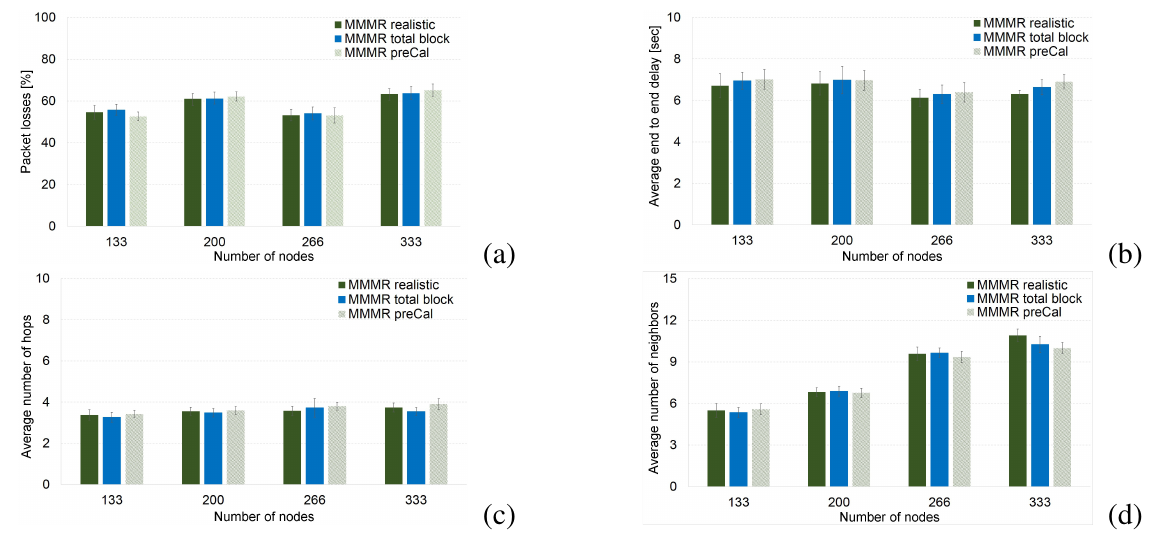
Figure 9. Building attenuation models comparison (Tarragona scenario) (CI 95%). ( a ) Percentage of packet losses; ( b ) average end-to-end delay; ( c ) average number of hops; ( d ) average number of